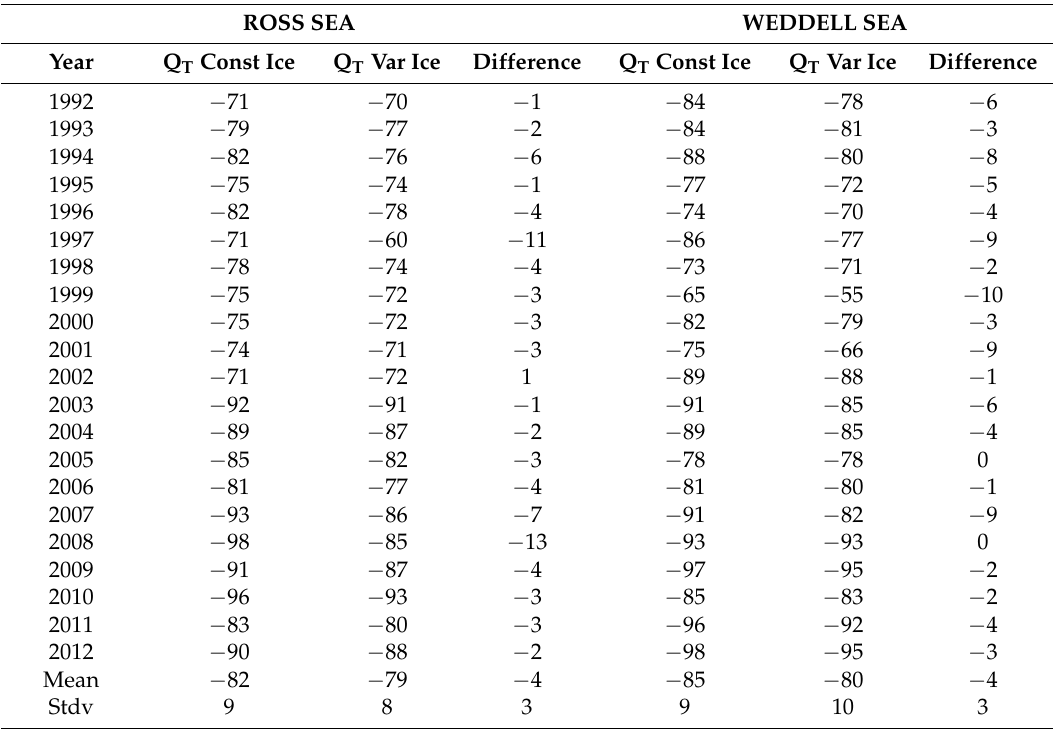
Table 1. Comparison between estimations of the net heat budget (Q T ) over the Ross and Weddell seas for the period 1992–2012. For both areas, ‘Q T const ice’ was estimated using the sea ice climatological year, while ‘Q T var ice’ was estimated using correspondent daily sea ice data. Q T is expressed in W · m − 2 . Surface Heat Fluxes Estimated Using Constant and Variable Sea Ice Data ROSS SEA WEDDELL